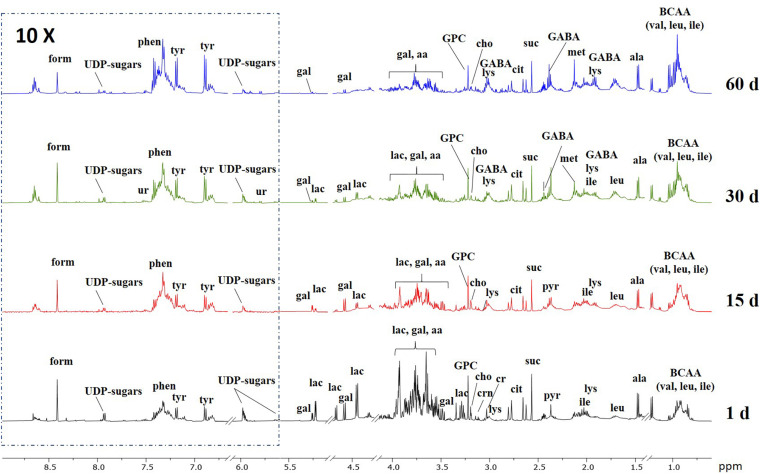
Representative 1H NMR spectra of the aqueous extracts of control Caciotta cheese at different ripening days. Abbreviations: aa, amino acids; ala, alanine; cit, citric acid; cho, choline; cr, creatine; crn, creatinine; form, formic acid; GABA, γ-aminobutyric acid; gal, galactose; GPC, glycero-phosphocholine; ile; isoleucine; lac, lactose; leu, leucine; lys, lysine; met, methionine; phen, phenylalanine; pyr, pyruvic acid; suc, succinic acid; tyr, tyrosine; UDP-sugars, uridine diphosphate-related sugars; ur, uracile; val, valine.